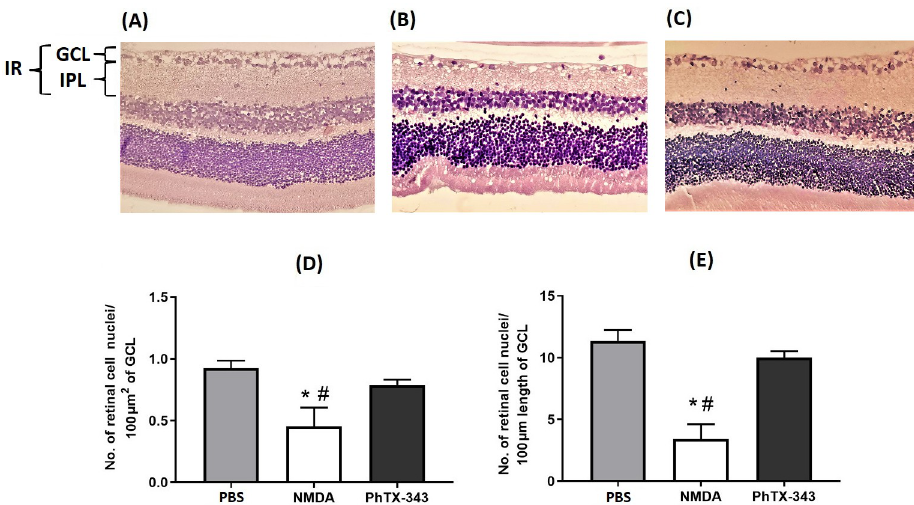
Fig 3. Photomicrographs of retinal sections from each group stained with hematoxylin and eosin (H&E) seven days after intravitreal injections. (A) PBS group presenting intact GCL, (B) NMDA group showing broad loss of retinal cell nuclei, (C) PhTX-343 pre-treatment group followed by NMDA administration after 24 h showing minimal loss of ganglion cells. The histological assessments were quantified with morphometric analysis and presented as a bar graph: (D) number of retinal cell nuclei per 100 μ m 2 of GCL area, (E) number of retinal cell nuclei per 100 μ m length of GCL. Data were analyzed using one-way ANOVA followed by post-hoc Tukey’s multiple comparisons test: � p < 0.05 versus PBS; #p < 0.05 versus PhTX-343 (Scale bar 100 μ m). GCL: ganglion cell layer, IPL: inner plexiform layer, IR: inner retina layer.